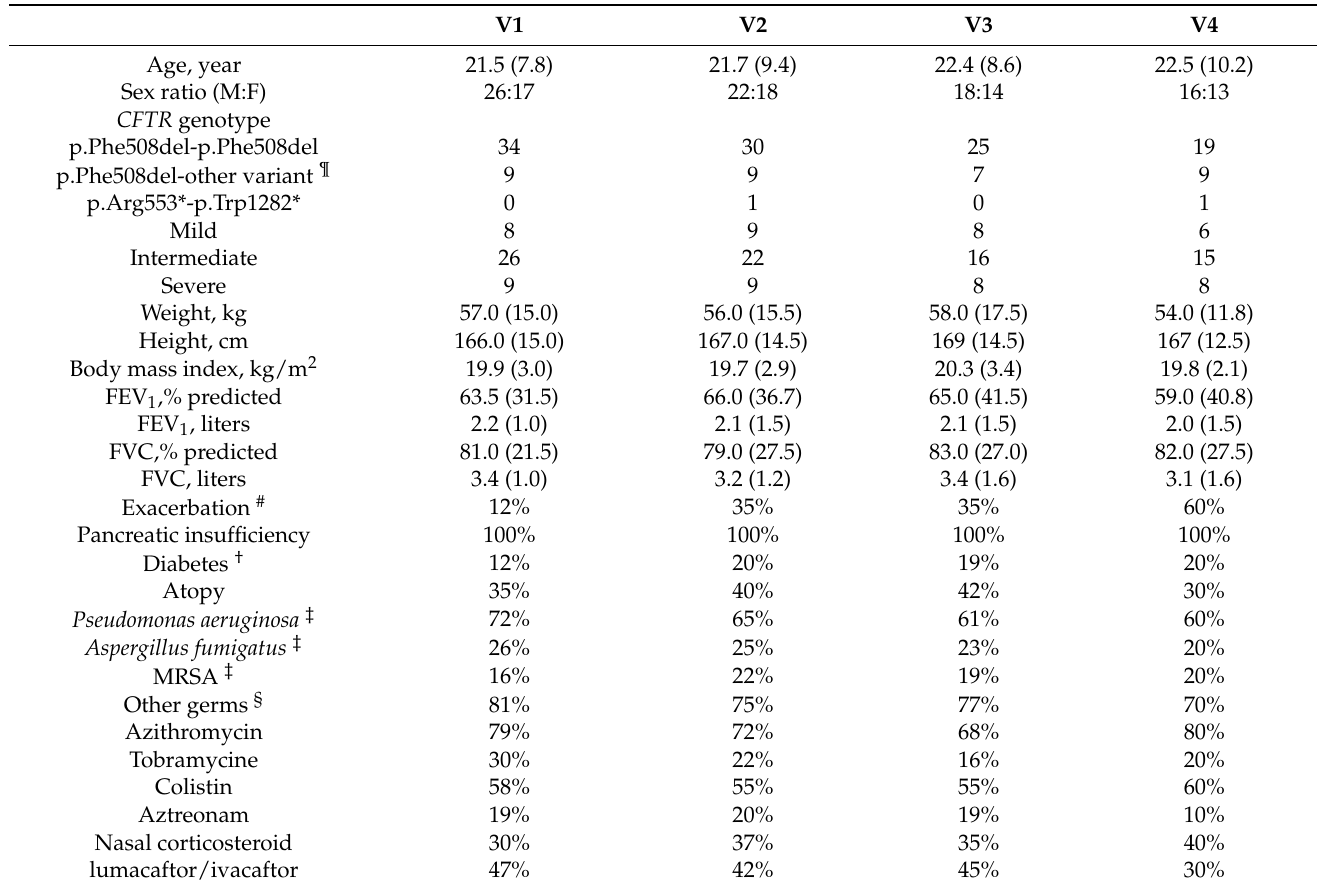
Table 2. MethylBiomark cohort: demographic and clinical data (number or percentage or median (iqr)) of patients who provided validated sputum samples at visit 1 to